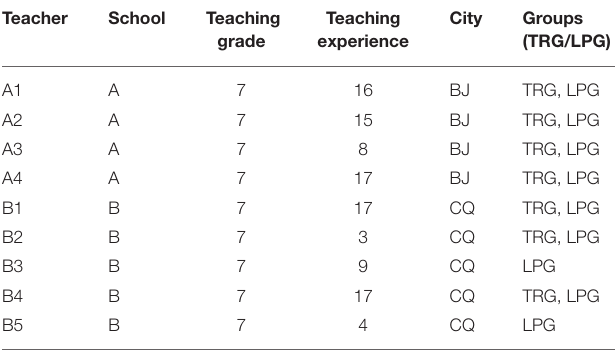
TABLE 1 | Teachers’ demographic